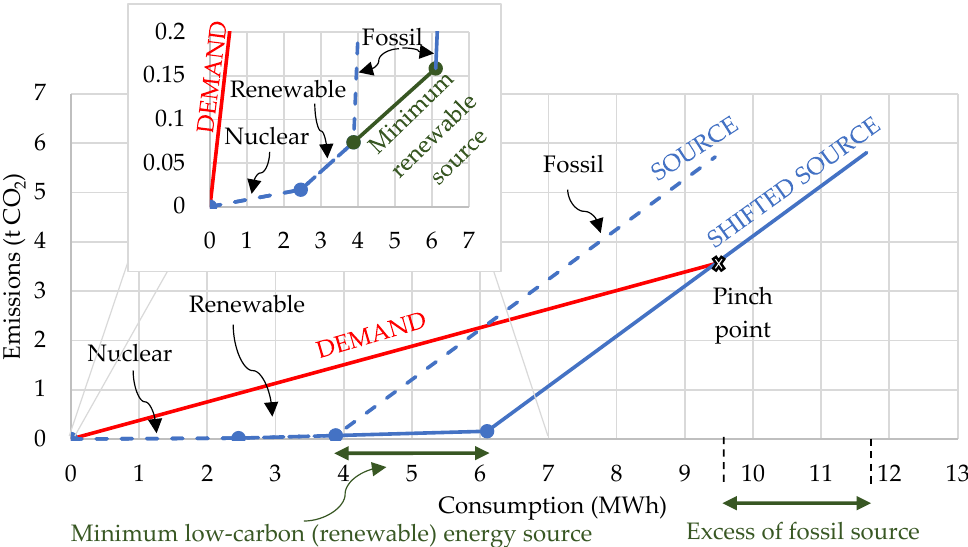
Figure 3. Pinch diagram for 1 t of aluminum slugs with a minimum low-carbon (renewable) source.